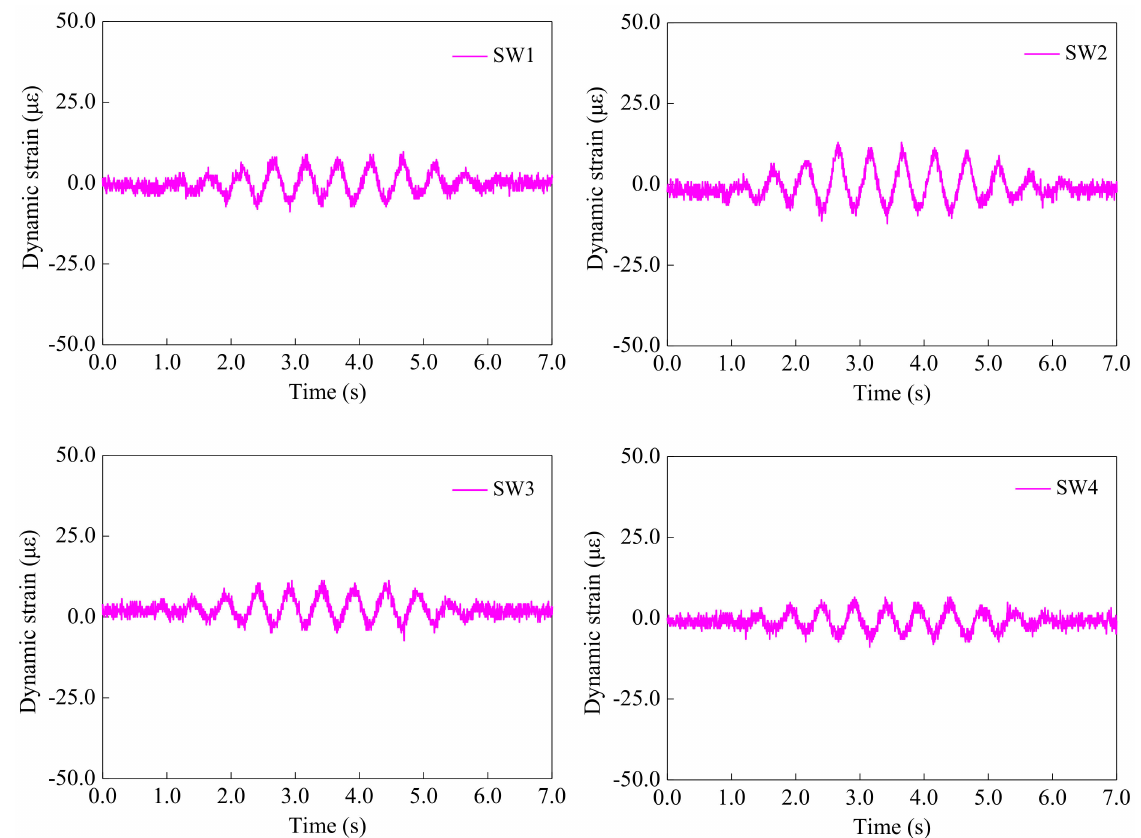
Figure 23. The dynamic strain of segments, with frequency of 2